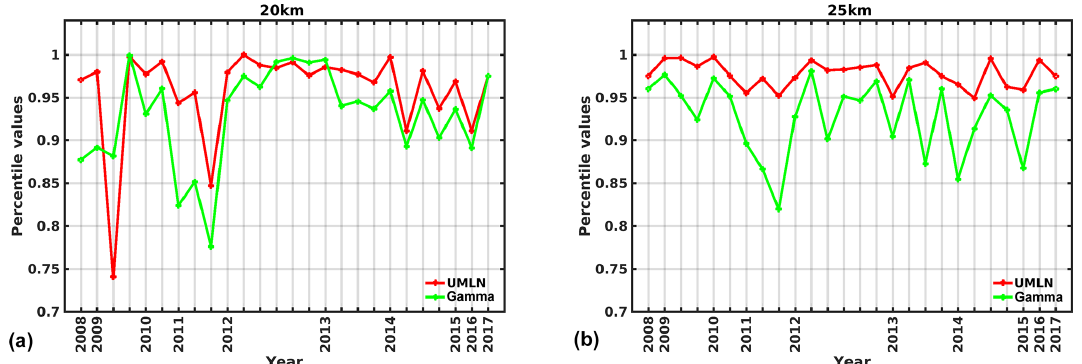
Figure 2. Percentile values computed for the χ 2 values of the UMLN (red line) and gamma (green line) distribution fits to 2008 to 2017 OPC data for altitudes 20km (a) and 25km (b) .